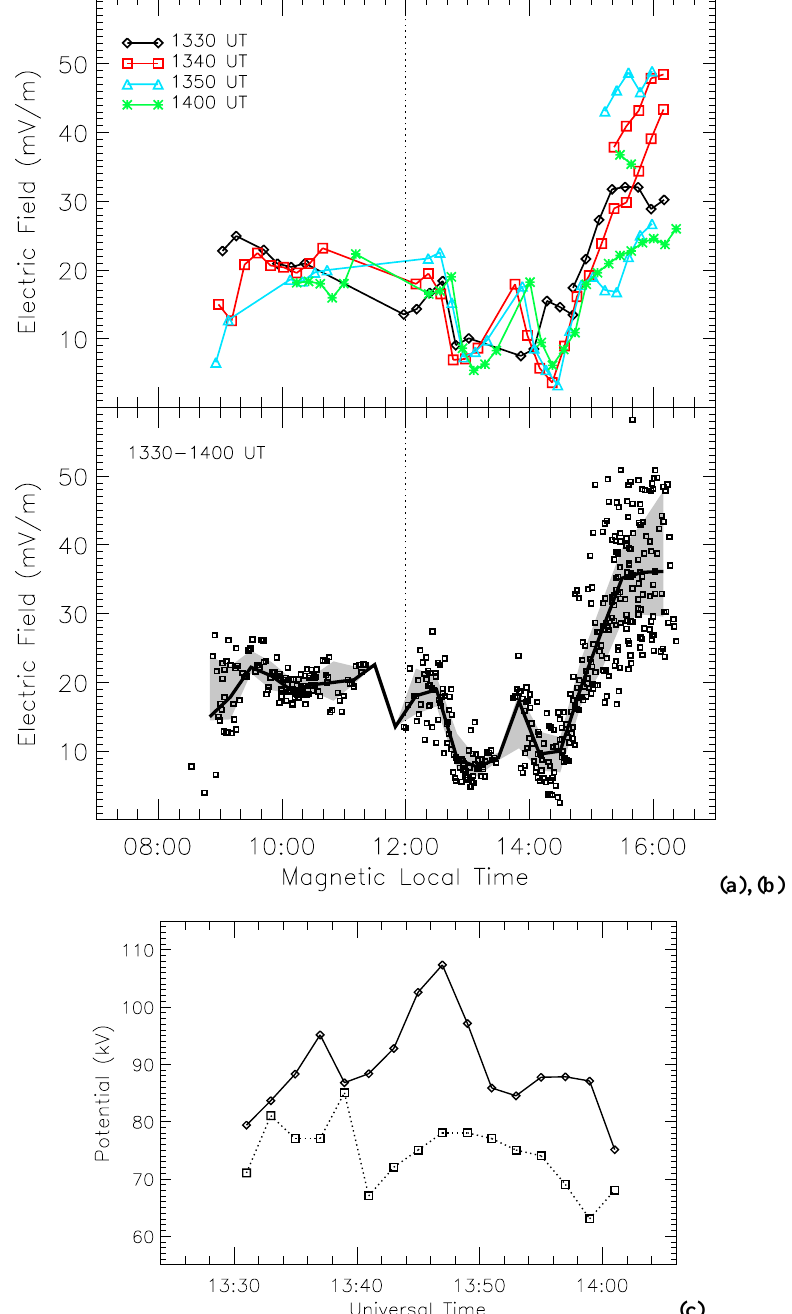
Fig. 7. Panel (a) : The reconnection electric field ( y -axis) measured at a range of MLTs ( x -axis) for 4 radar scan periods. Panel (b) : all the reconnection electric field values measured from 13:30–14:00 UT. The solid line is the median reconnection electric field for a given MLT, the shading marks the upper and lower quartiles. Panel (c) : the total reconnection potential ( y -axis) measured across the dayside merging line sampled by the radar coverage ( ∼ 7h of MLT, see text for discussion) over the UT period ( x -axis) of the study is shown by the solid line. The total crosspolar cap potential, as determined by the convection mapping process, is shown by the dotted